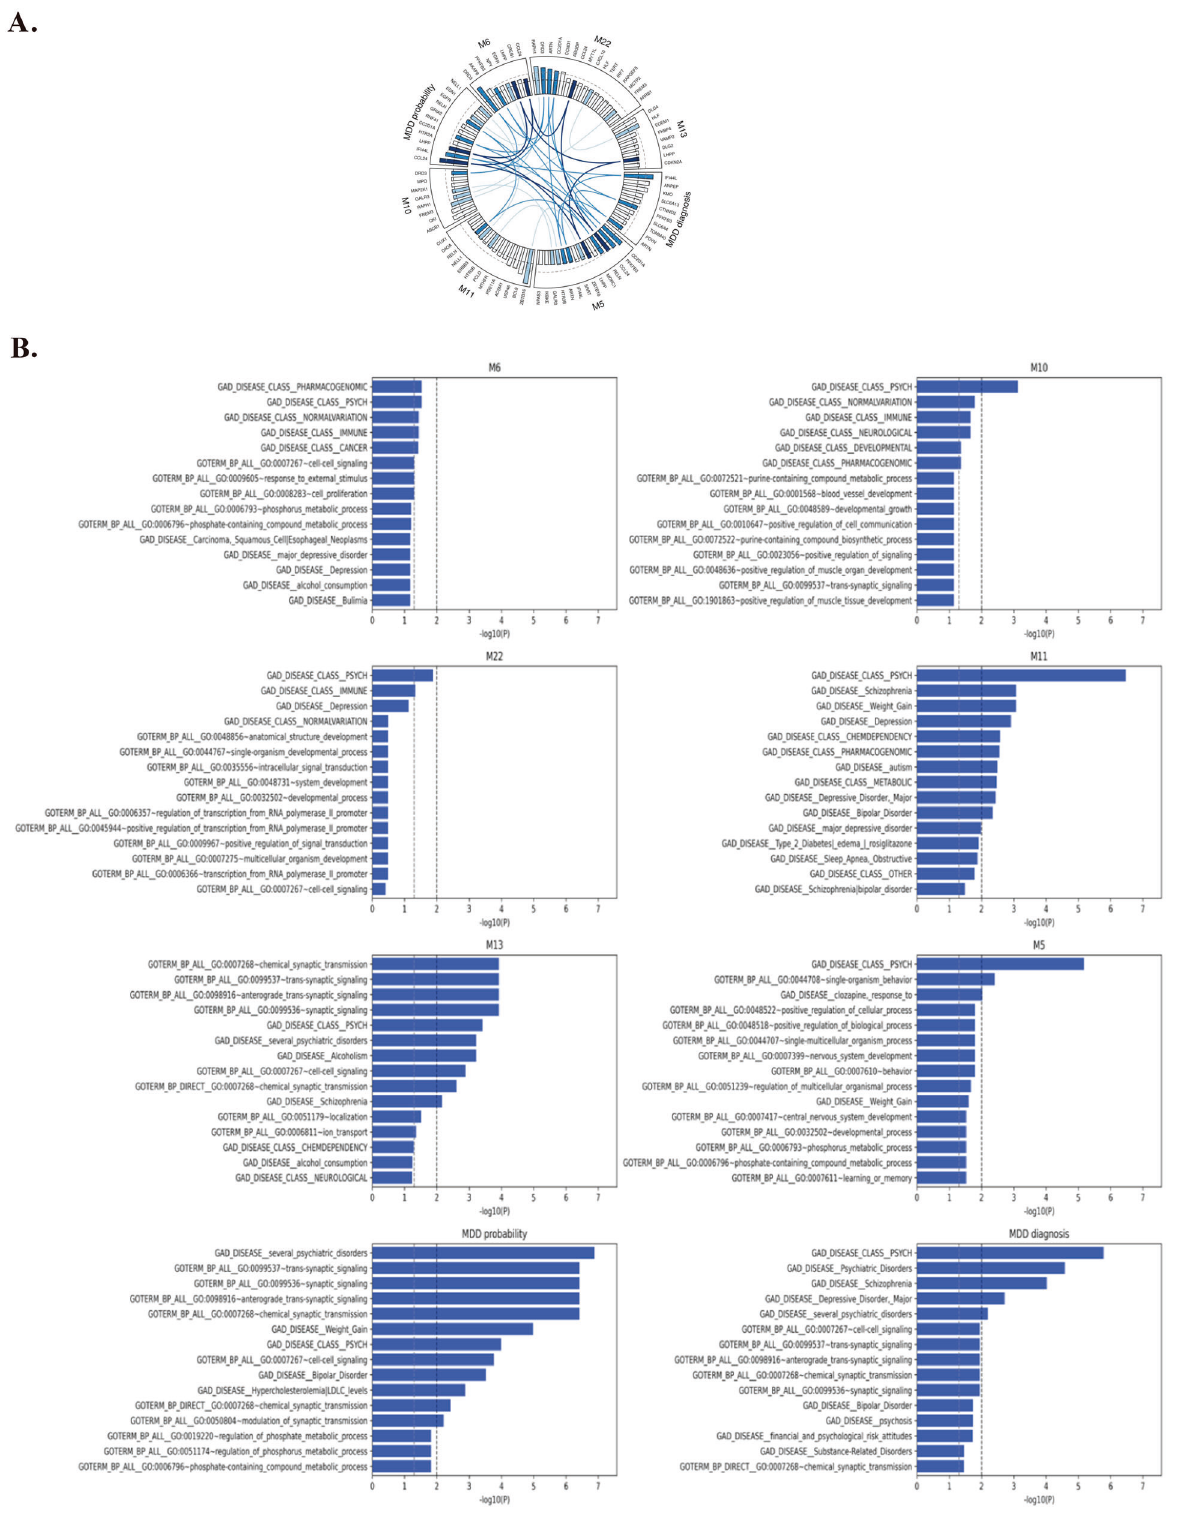
Fig. 5 Pascal gene scores and MDD signi fi cant pathways associated with Top six meta-phenotypes, MDD probability, and MDD diagnosis. A Pascal gene scores for Top six meta-phenotypes, MDD probability, and MDD diagnosis, respectively; B MDD signi fi cant pathways associated with top six meta-phenotypes, MDD probability, and MDD